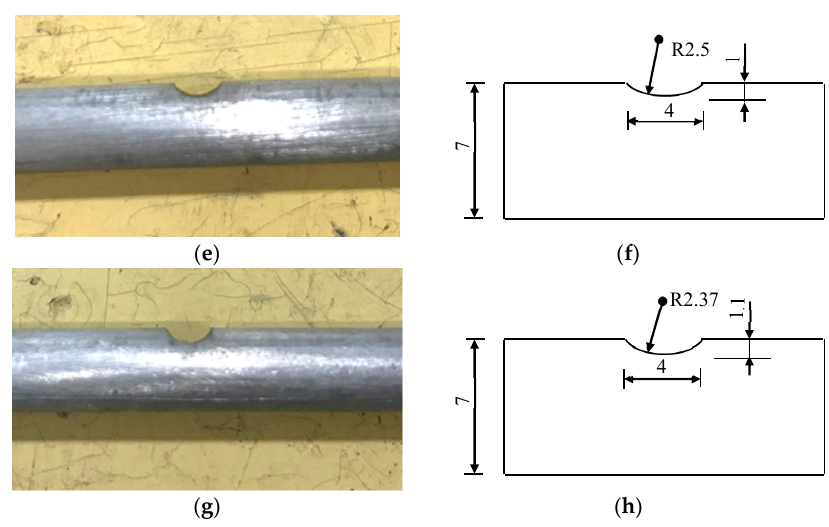
Figure 15. Wire specimens with different semi-ellipsoidal notches of different depths. ( a ) No. D-1 Steel wire specimen; ( b ) dimension of No. D-1 steel wire; ( c ) No. D-2 steel wire specimen; ( d ) dimension of No. D-2 steel wire; ( e ) No. D-3 steel wire specimen; ( f ) dimension of No. D-3 steel wire; ( g ) No. D-4 steel wire specimen; and ( h ) dimension of No. D-4 steel wire.